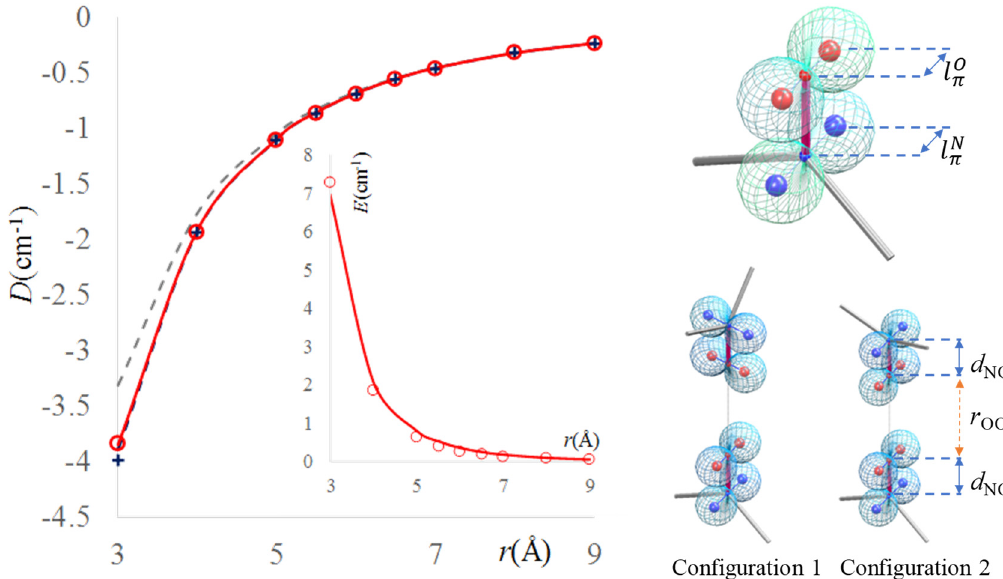
Figure 10. The modeling of ZFS parameters. Left panel: the dashed grey line estimated D parameter, assuming point-like spins in the middle of the NO groups (approximation common for Configurations 1 and 2); the plus ( + ) and open circles (o) symbols correspond to computed D values for the respective Configuration 1 and 2. The lines passing through these points correspond to the fit with the model sketched in the right-side panel. The inset is dedicated to the E parameter, computed (circle symbols) and modelled (line), for Configuration 2, the respective values being null for the Configuration 1. Right-side panel: in upper part, the model with four points carrying spin density, in the barycentre of p-type lobes of oxygen and nitrogen (red and blue spheres); the bottom part shows the situations corresponding to Configurations 1 and 2; the TEMPO units are schematized by their C-NO-C moieties.